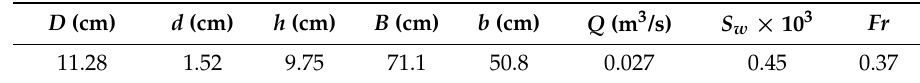
Figure 18. Sketch of a cross-section in a simplified compound channel. Table 1. Data of the physical